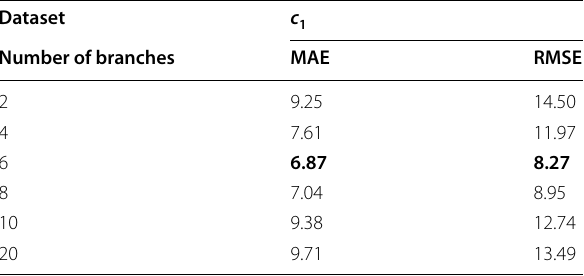
The bold value means the best results Table 9 Comparison of different numbers of GRU layers in the MCGRU model